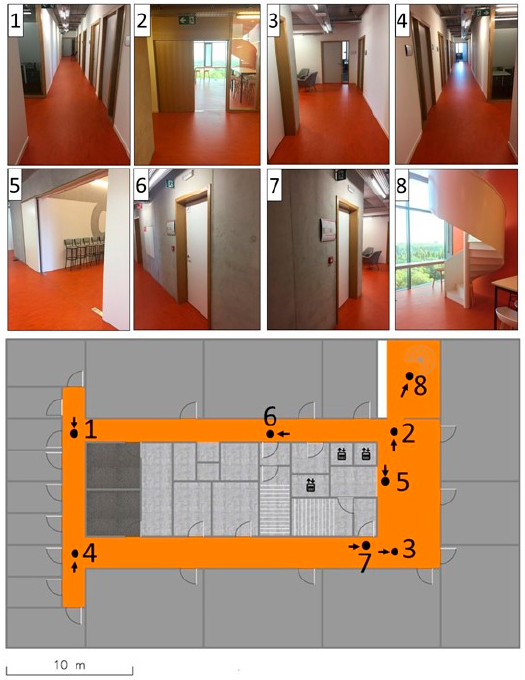
Figure 1. Floorplan of the iGent tower (ninth floor) with eight decision points. From every decision point an image is included, taken in the direction of the